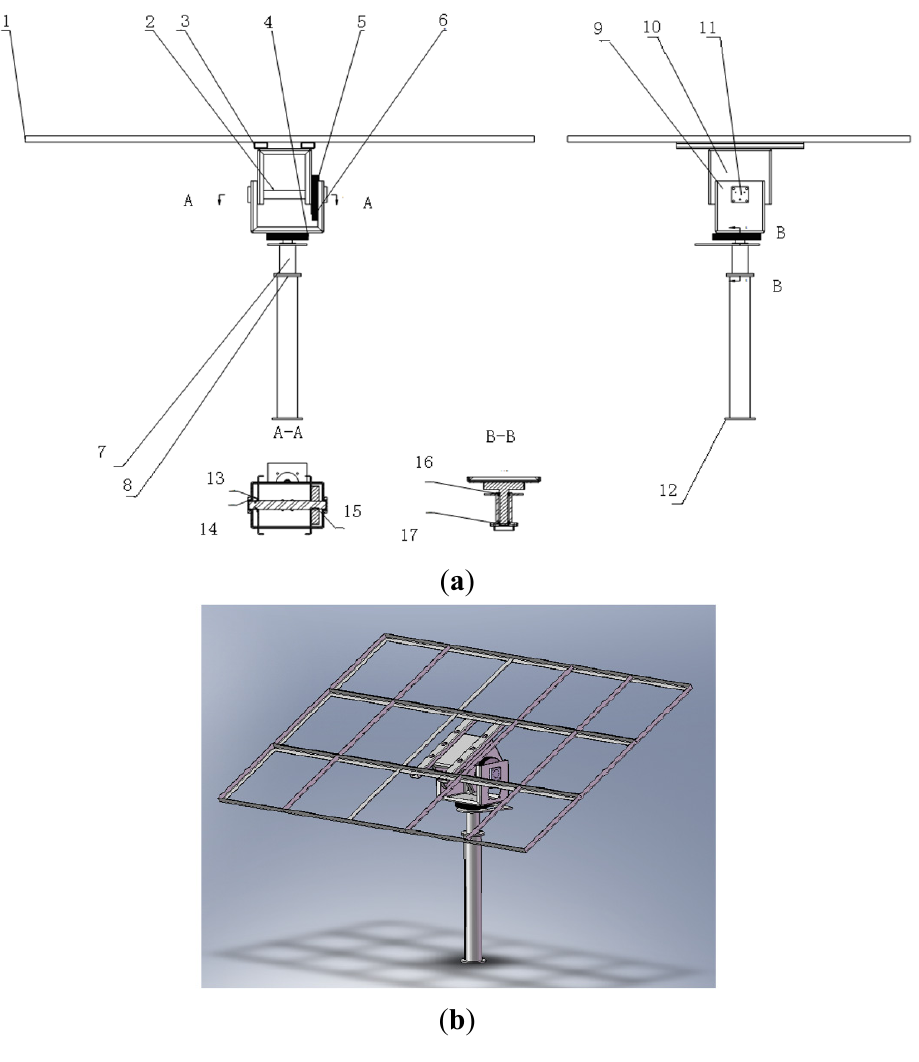
Figure 12. ( a ) Assembly diagram. 1 solar panels: angle steel bracket; 2 pitch-axis; 3 rectangular steel piece; 4 azimuth-axis gear; 5 pitch-axis great gear; 6 pinion; 7 two-axles-bearing pedestal; 8 pillar; 9 lower base element; 10 upper base element; 11 axle-bearing pedestal; 12 flange; 13 button shaft flange; 14 bearing; 15 flat key; 16 bearing; 17 bearing block shoulder; ( b ) Overall diagram. The system follows solar irradiance